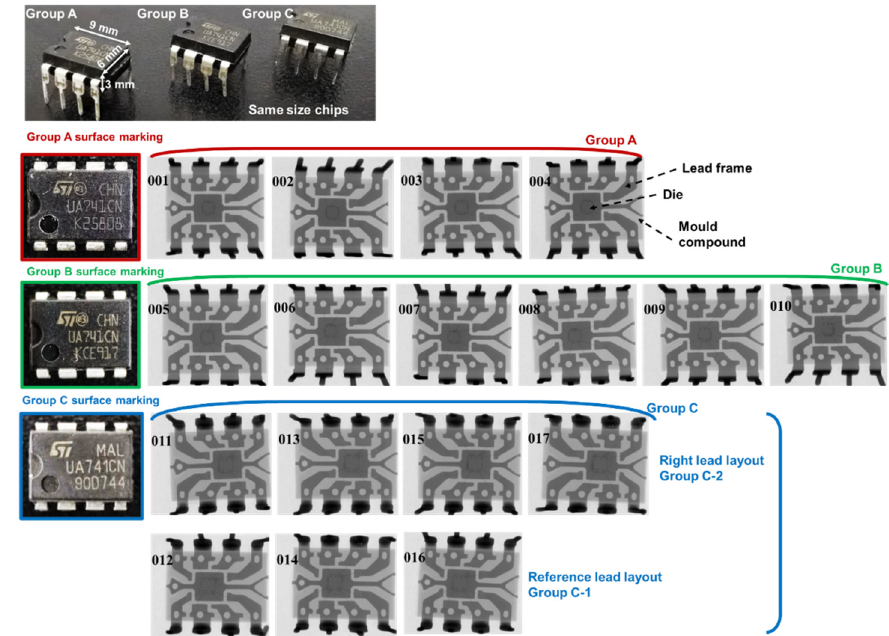
Figure 4. The dimensions, digital images and X-ray images of three groups of chips, where the differences in surface and inner structure can be clearly observed.